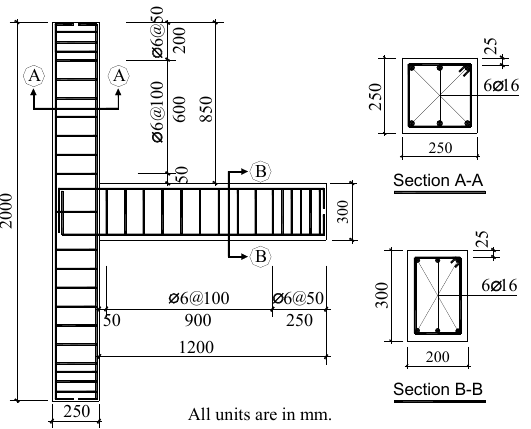
Figure 1. Geometry and reinforcement details (all dimensions are in mm; Ø and @ refer to the di- ameter of rebar and the stirrup spacing, respectively).